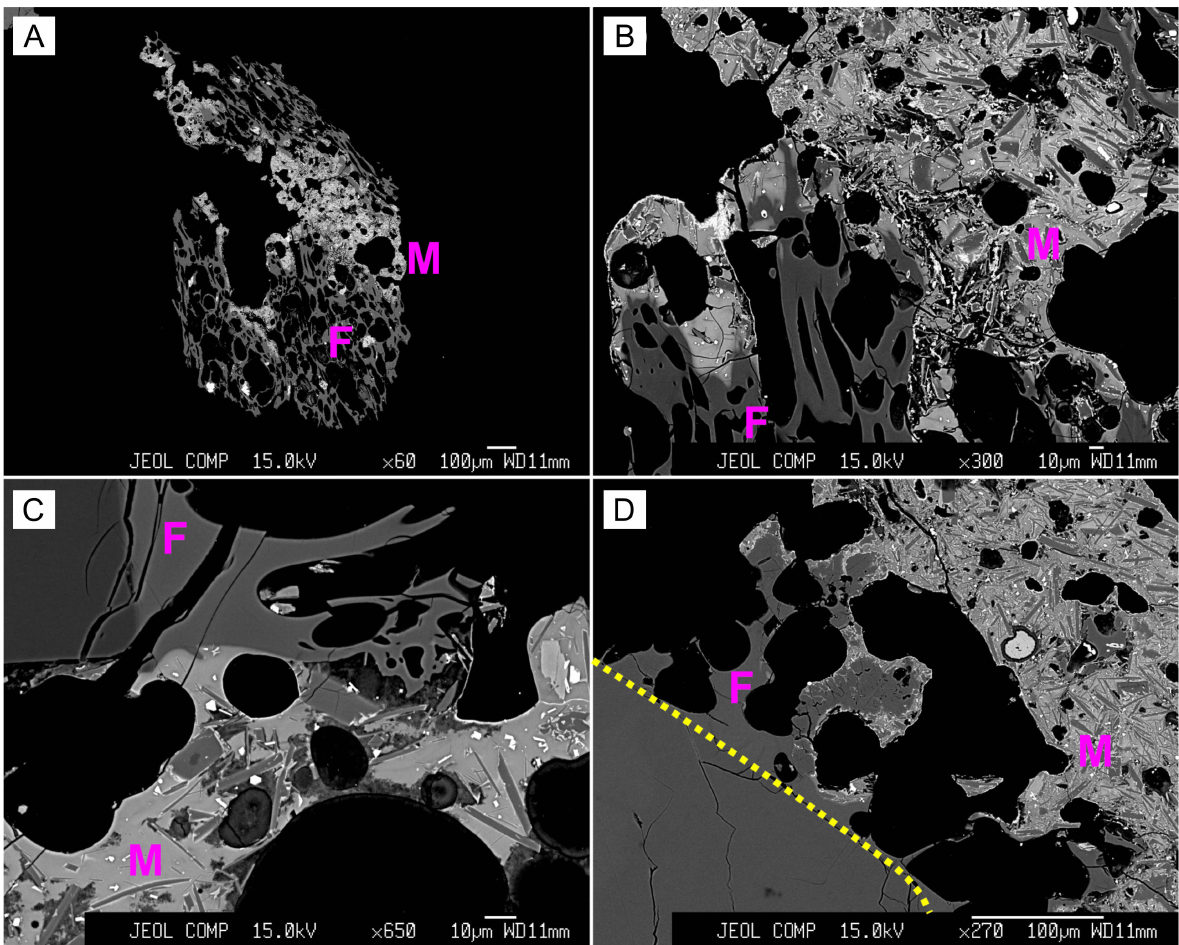
Figure 5: Representative BSE images of mineral and glass textures from the mingled fall deposit. [A] Mixed clast showing the contact between the darker grey, vesicular felsic glass (F) and the microcrystalline mafic glass (M), scale bar is 100 µm in length; [B, C] Contact between felsic glass (F) and mafic microcrystalline glass (M) preserv- ing fine scale structures along the interface of the two di ff erent glasses, scale bar is 10 µm in length; [D] ‘mafic’ feldspar mineral from the scoria material showing a felsic glass selvedge (F) in contact with the microcrystalline mafic glass (M), scale bar is 100 µm in length. Contact between feldspar and felsic glass shown by dashed